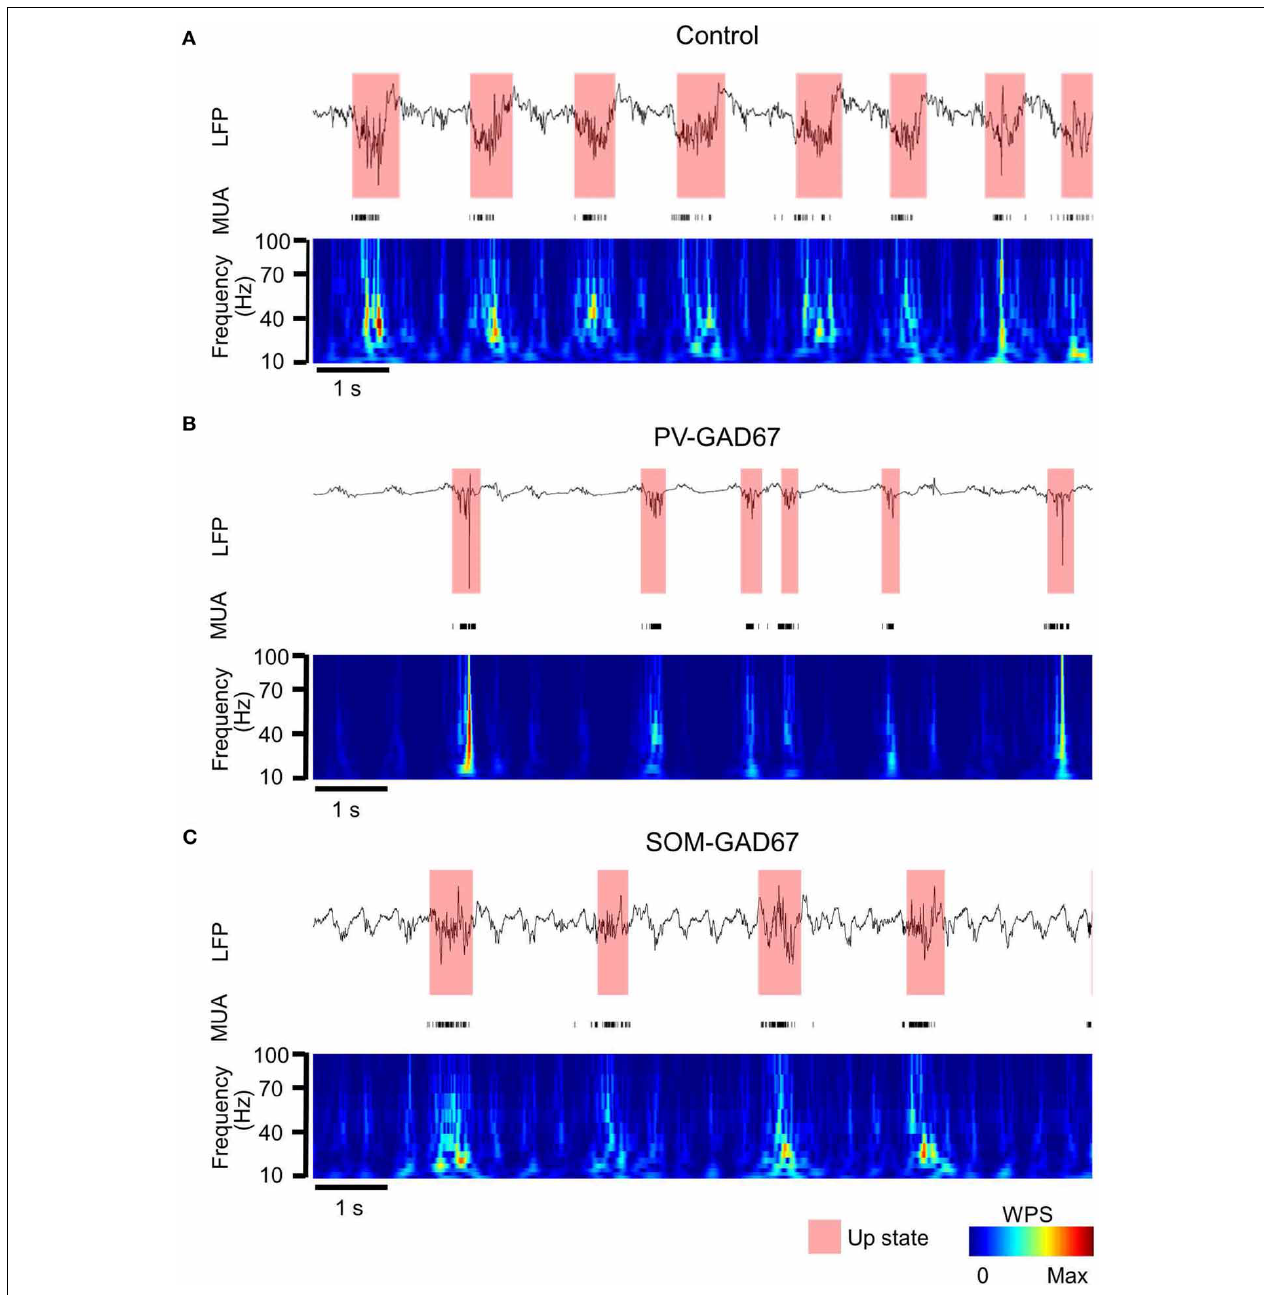
FIGURE 2 | LFP and MUA temporal profile and the up state detected from the WPS of the LFP. (A) The LFP temporal profile example from channel 14 (top), the MUA temporal profile from all channels (middle), and the WPS (bottom) of a control mouse (semi-transparent red, up state detected from the WPS; colored bar, normalized amplitude of WPS). (B) PV-GAD67